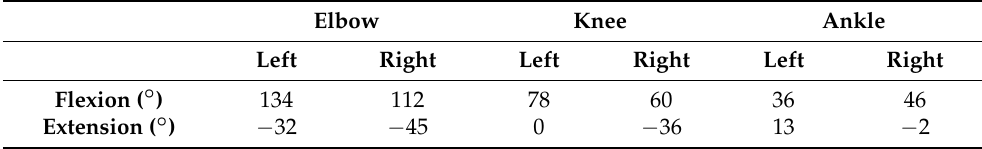
Table 1. Range of motion of the flexion and extension movement of the elbow, knee, and ankle